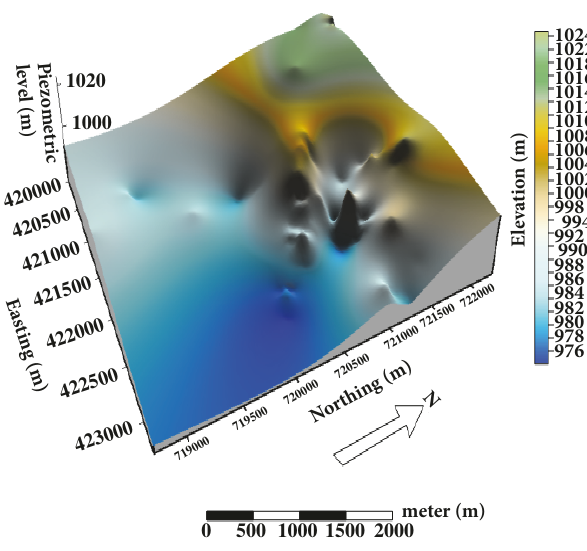
Figure 21: 3D piezometric model of the study